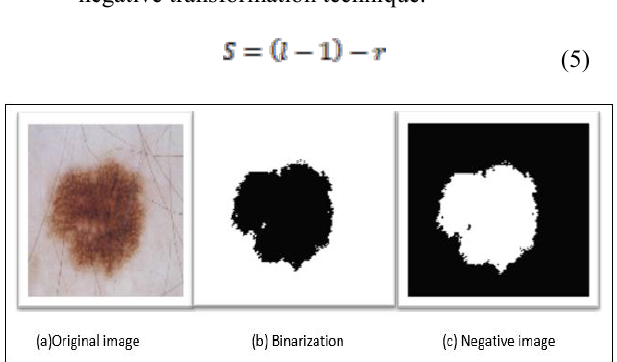
Figure 7. Results after applying image restoration Techniques